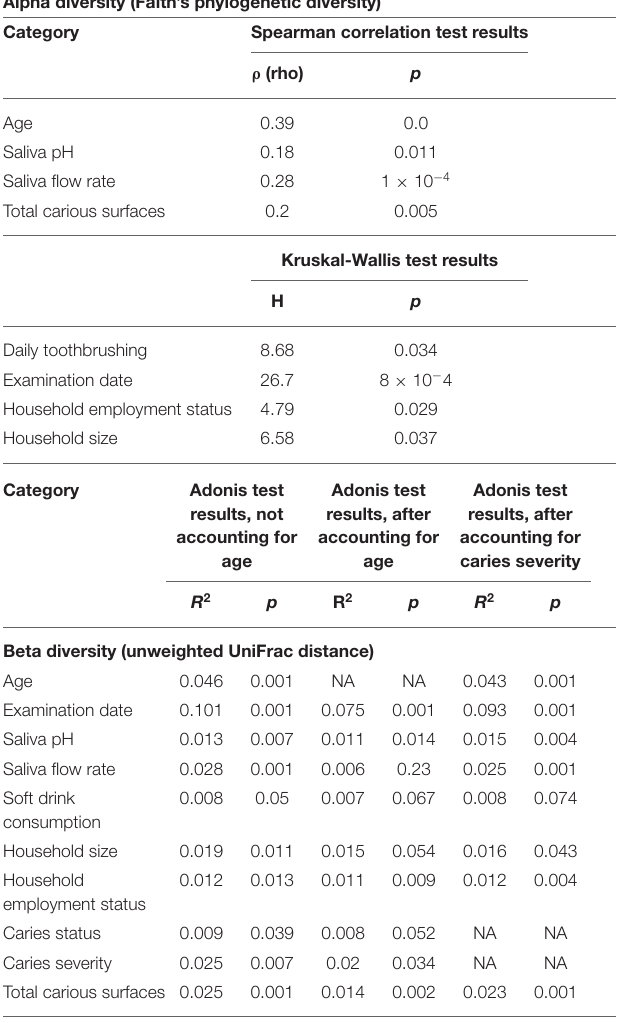
TABLE 2 | Metadata factors linked to significant differences in alpha and beta diversity across sample groups. Alpha diversity (Faith’s phylogenetic diversity)